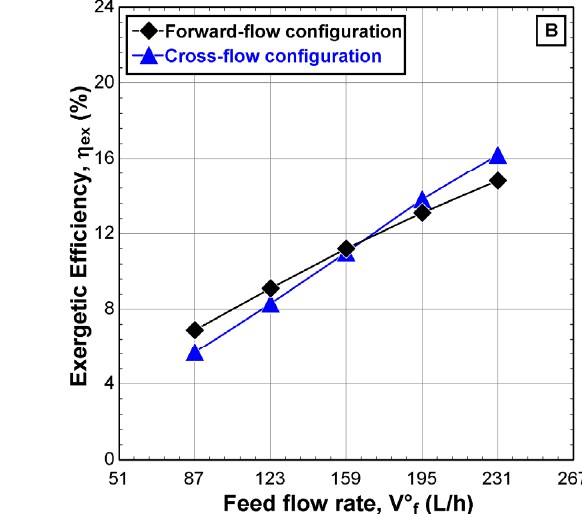
Table 5. Comparison of the present results with those of [10,30].